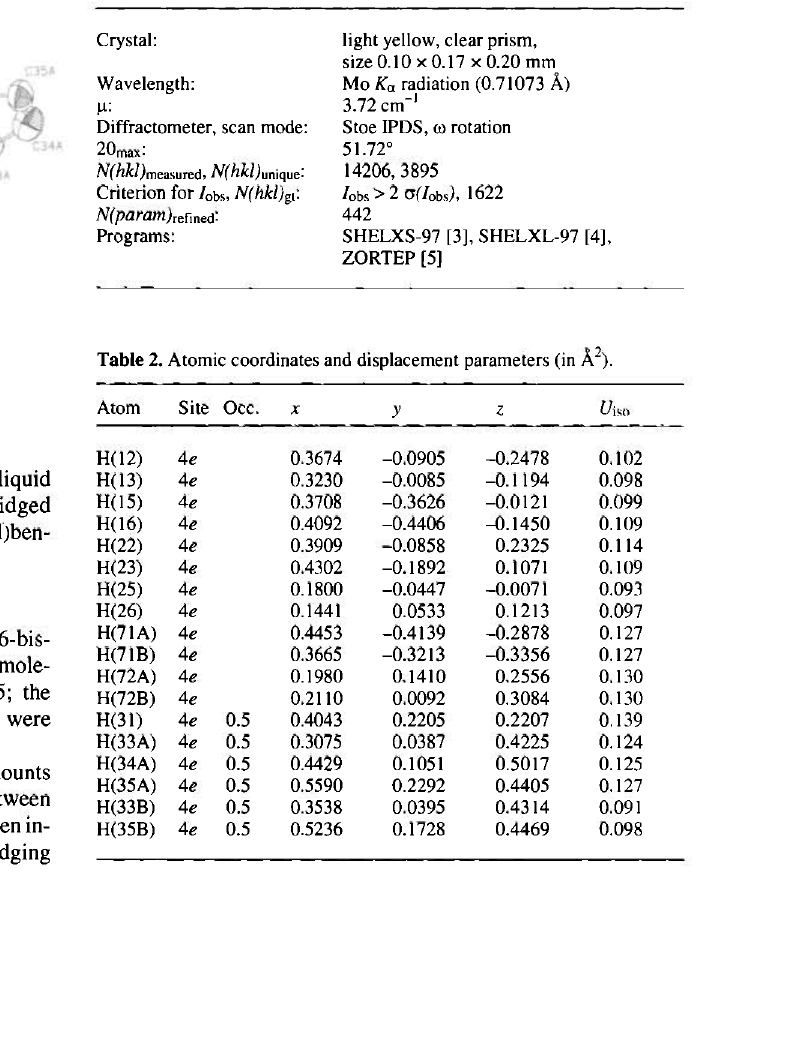
Table 2. Atomic coordinates and displacement parameters (in Ä 2